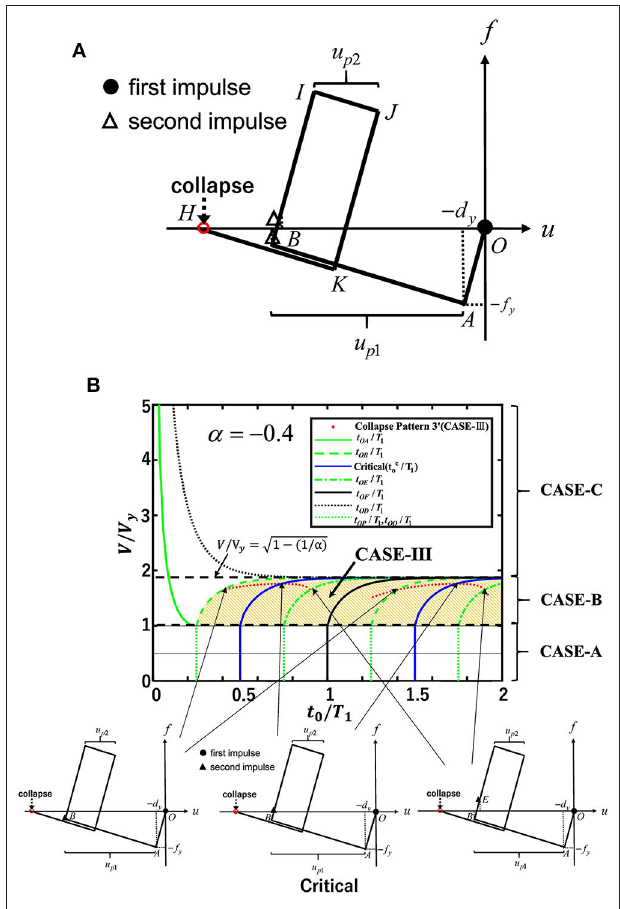
FIGURE 7 | Collapse pattern 3 ′ (CASE-B and CASE-III). (A) Restoring-force characteristic. (B) Second impulse timing t 0 / T 1 -input velocity relation.